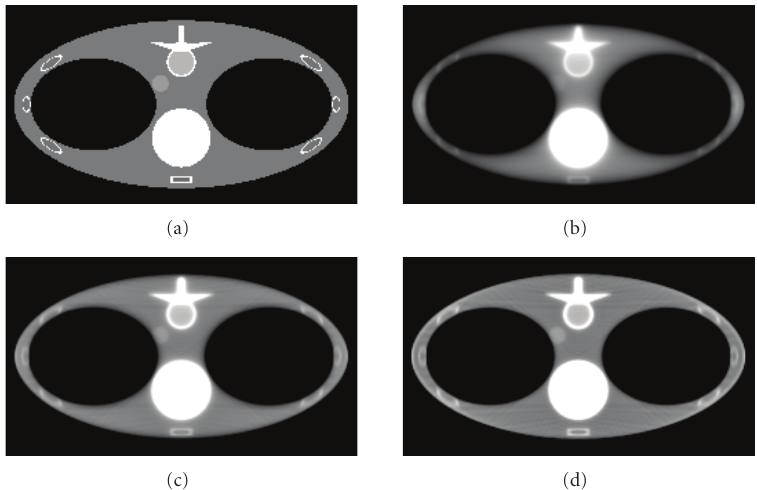
Figure 2: Comparison of images reconstructed using line-SART algorithm using a line source of length 3cm at di ff erent iteration numbers. (a) Original Image. Reconstructed images in (a), (b), and (c) are, respectively, at 30, 60, and 100 iterations. Display window is [0 . 8,1 . 2].